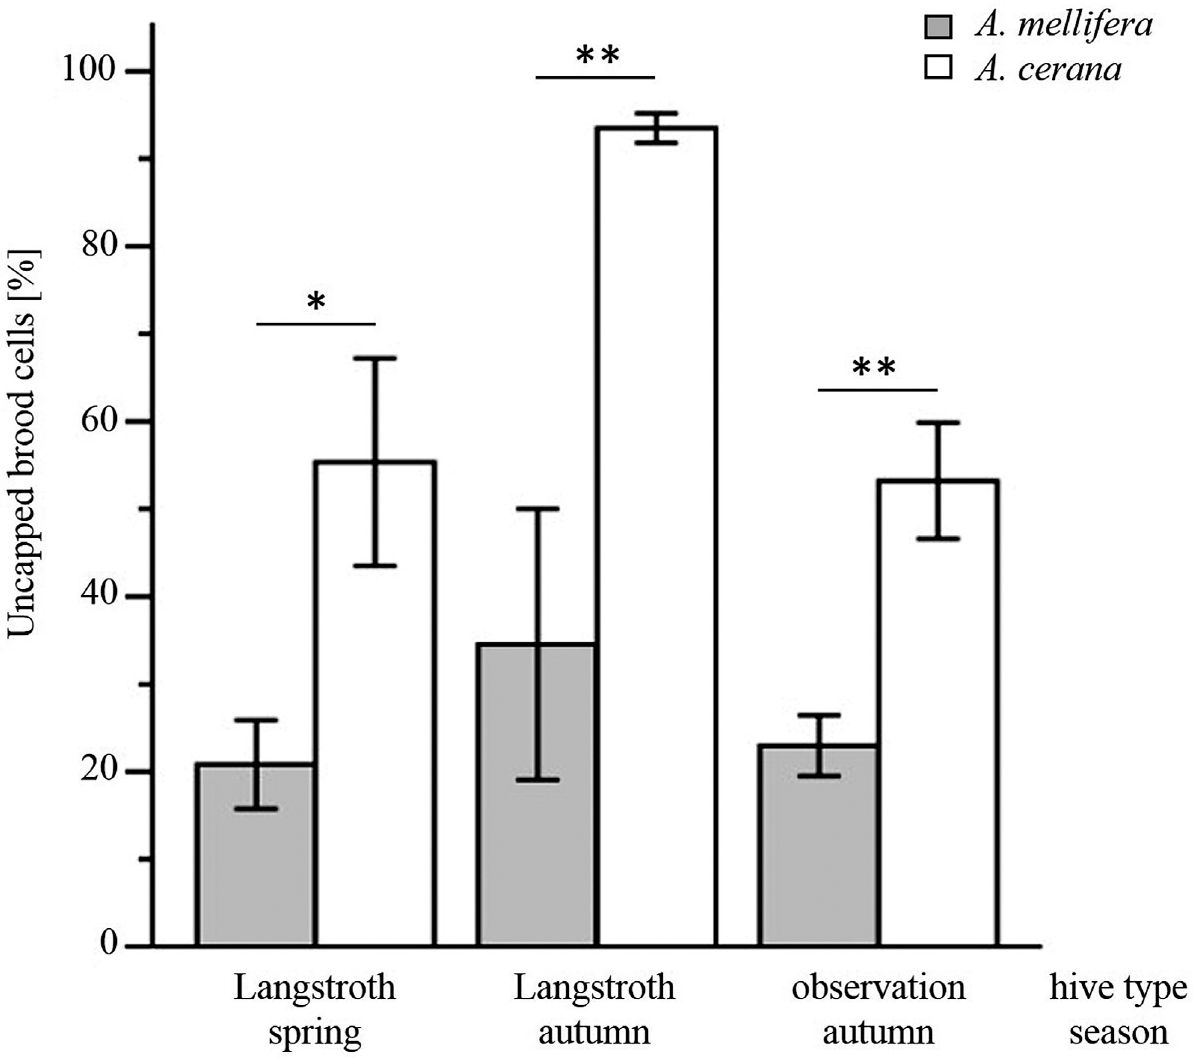
Fig 2. Uncapping of freeze-killed brood cells in colonies of A . mellifera and A . cerana three hours (Langstroth hives) and two hours (observation hives) after freeze-killing. Measurements are reported for spring and autumn. Means, standard errors and results of the independent samples t-test are shown ( * : p < 0.05; ** : p <